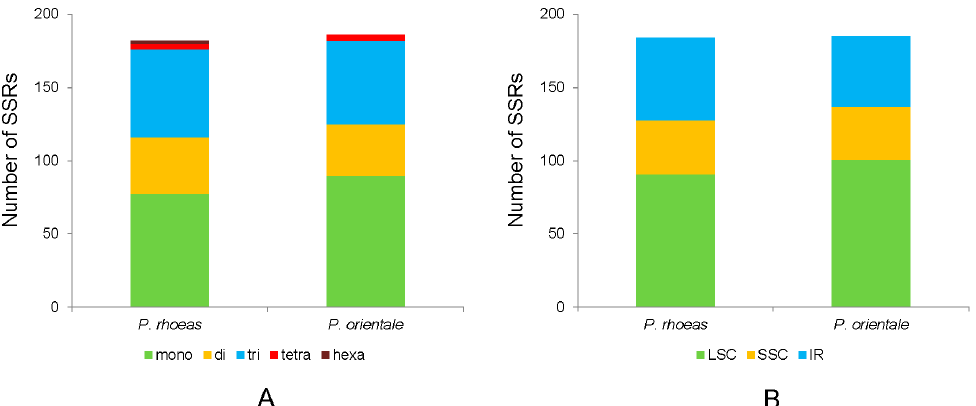
Figure 3. Distribution of simple sequence repeats (SSRs) in the chloroplast genomes of two Papaver species. ( A ) SSR type distribution in the chloroplast genomes of two species. ( B ) Proportion of SSRs in different genomic regions of the chloroplast genomes of two species. Table 3. Types and amounts of SSRs in the chloroplast genomes of P. rhoeas and P. orientale